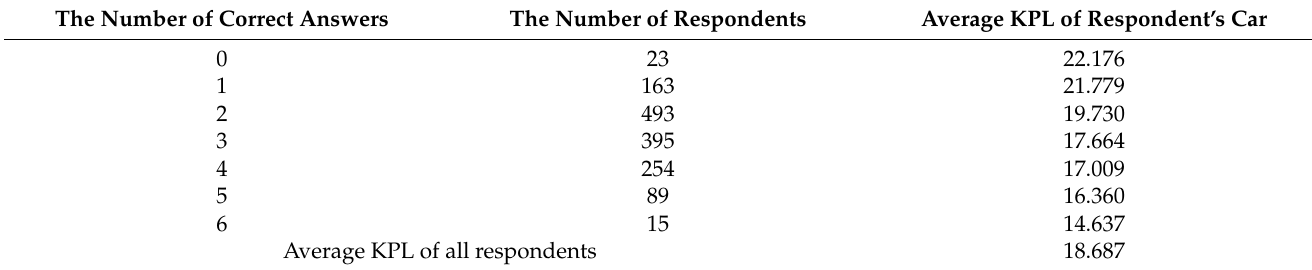
Table 4. The survey result of questions about KPL